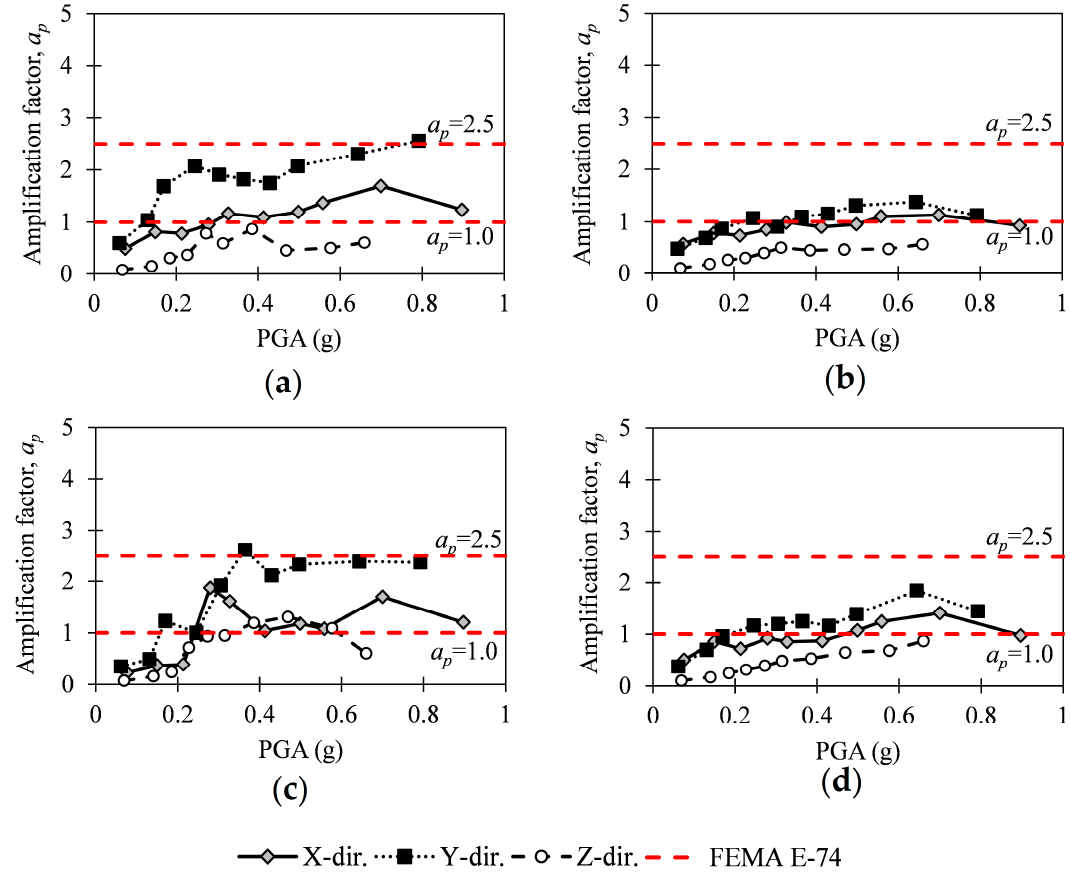
Figure 15. Amplification factor of test specimen at different locations of accelerometers. ( a ) At top beam; ( b ) At center coil; ( c ) At bottom beam; ( d ) At left coil.